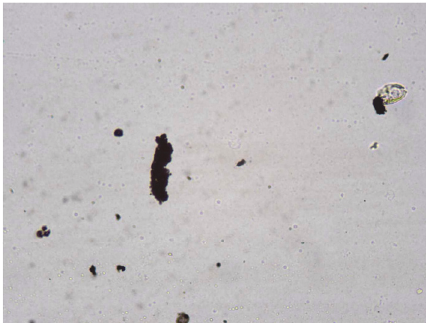
Figure 4: Optical microscope image of CNT dispersion after the treatment with 1400 J/mL of US energy, magnified 20 times.